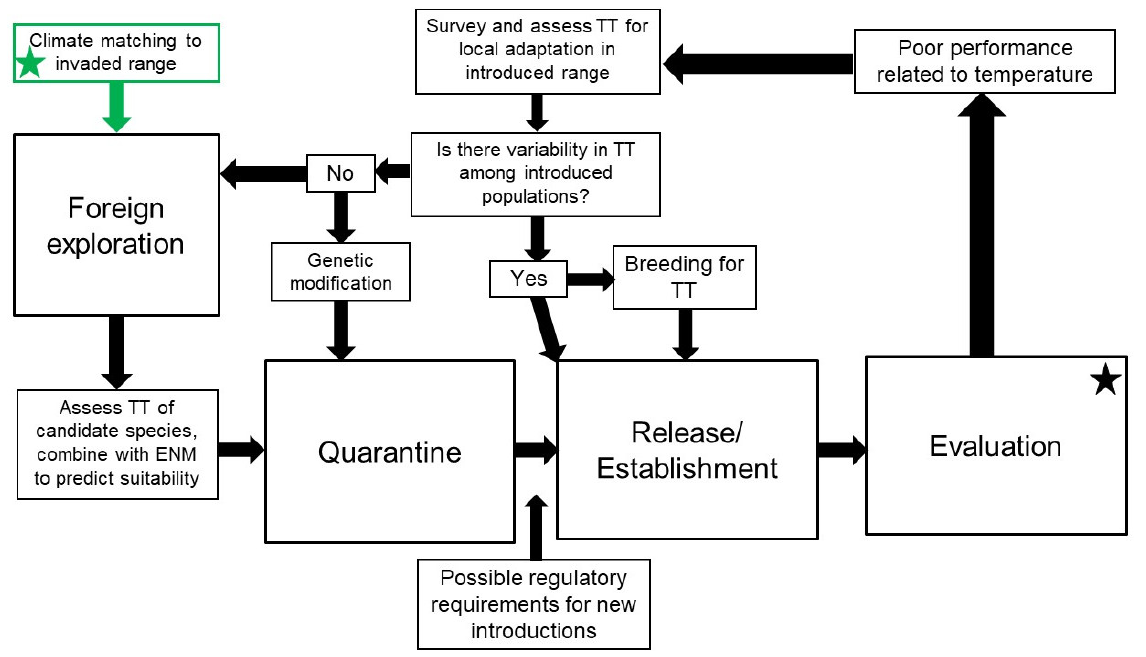
Figure 2. Proposed workflow for improving weed biological control outcomes where climate mismatches have been identified. Stars indicate workflow starting point for improving existing (black star) or developing new (green star) agents. Although not explicit in the diagram, at any point during agent development, it may be necessary to return to foreign exploration to source new agent genotypes or other candidate agents. TT = thermal tolerance; ENM = environmental niche modeling.